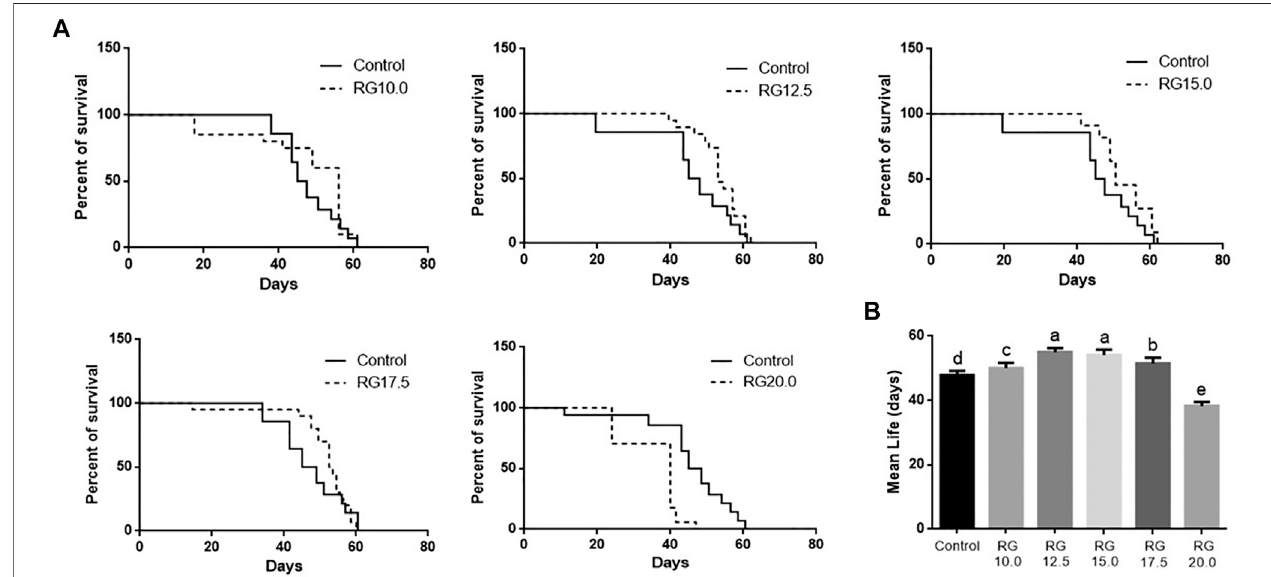
FIGURE 2 | Red ginseng on prolonging life span of male D. melanogaster ; B. Statistical analysis of data. The different lowercase letters mean signi fi cant difference at a 5% level with each treatment group.; Abbreviation: RG, red ginseng.